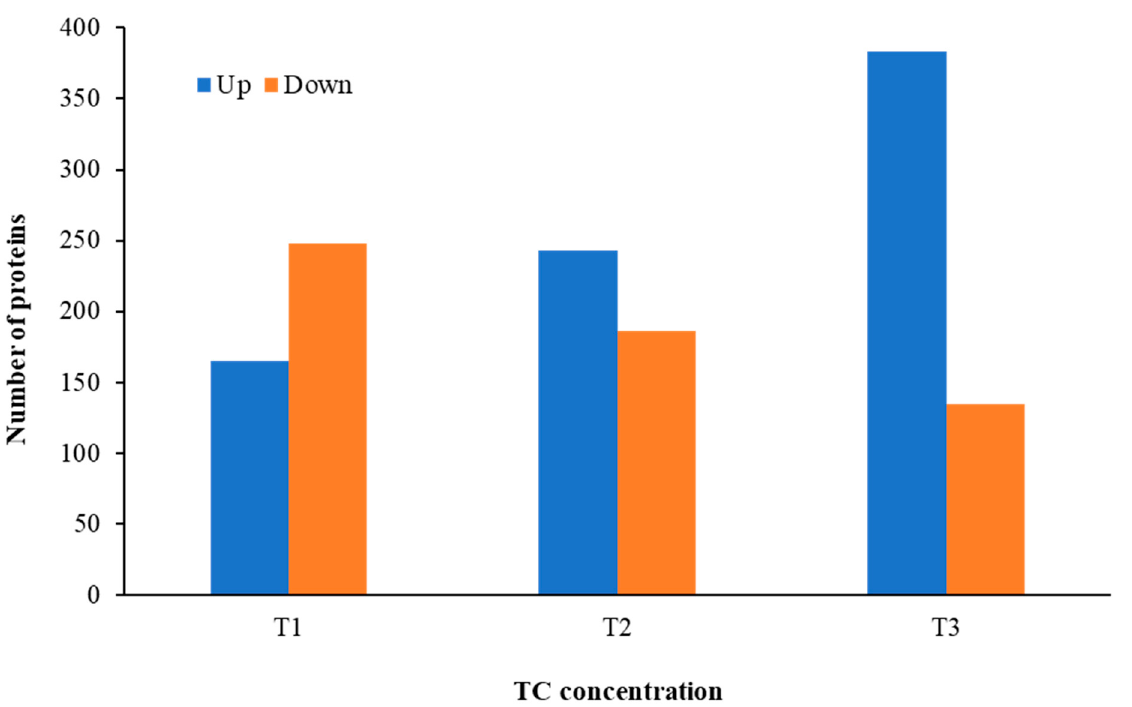
Figure 7. The number of differentially expressed proteins identified from S. epidermidis strain RP62A biofilms grown with sublethal MIC of TC. T1: 1/8 MIC, T2: 1/4 MIC, T3: 1/2